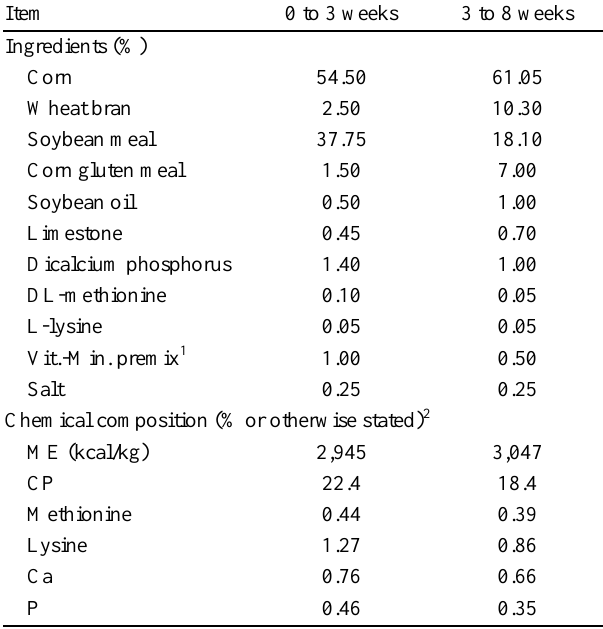
Table 1. Formula and chemical composition of basal diet